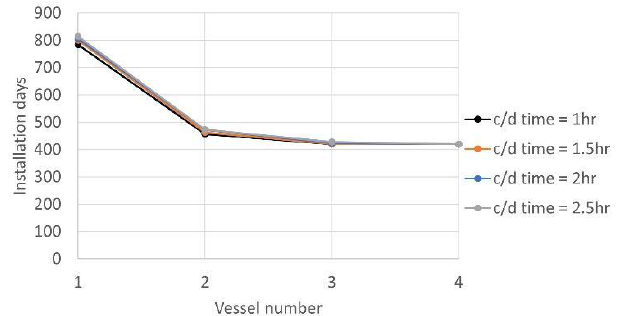
Fig. 15. Installation time against number of vessels for various connection/disconnection times, in the case of assembly team = 3.